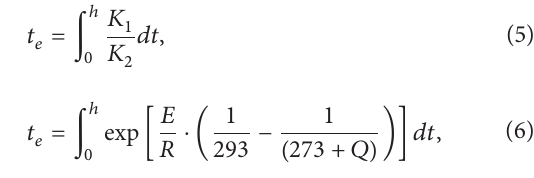
Figure 1: Photo of specimens inside the oven and